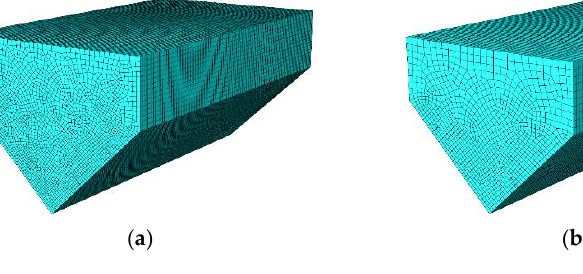
Figure 10. Comparative view of the three FEM mesh schemes: ( a ) fine mesh; ( b ) medium mesh; ( c ) coarse mesh. ( c ) coarse mesh. Table 4. Grid parameters of each FEM mesh scheme. Table 4. Grid parameters of each FEM mesh scheme.